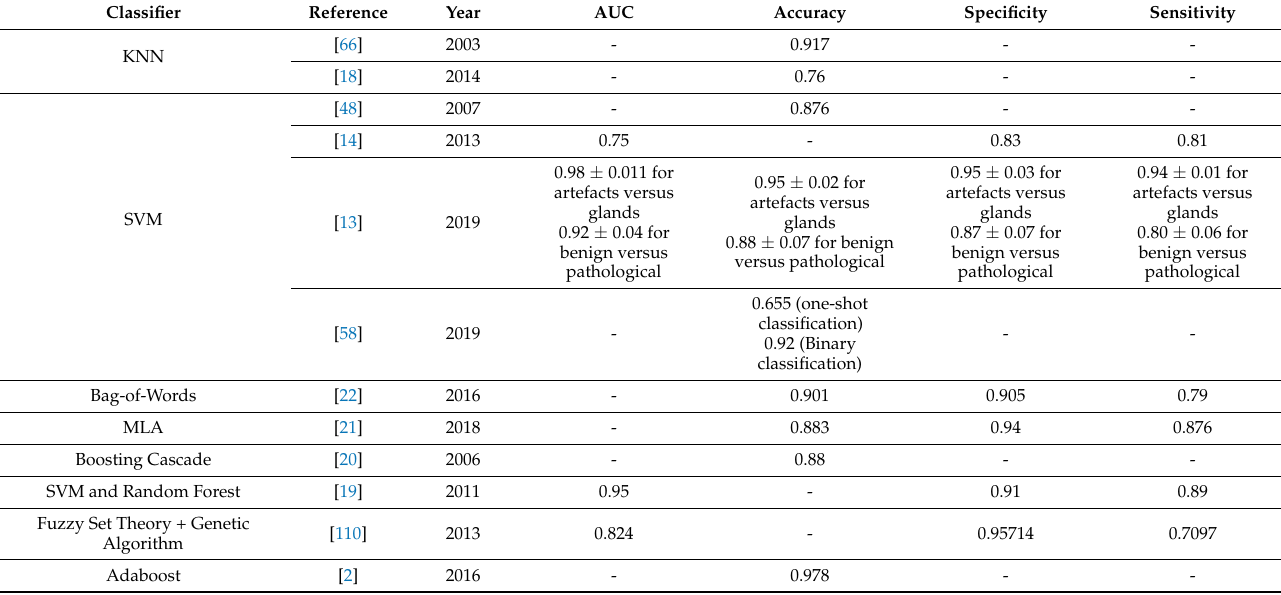
Table 4. Summary of publications focused on Prostate histopathology image